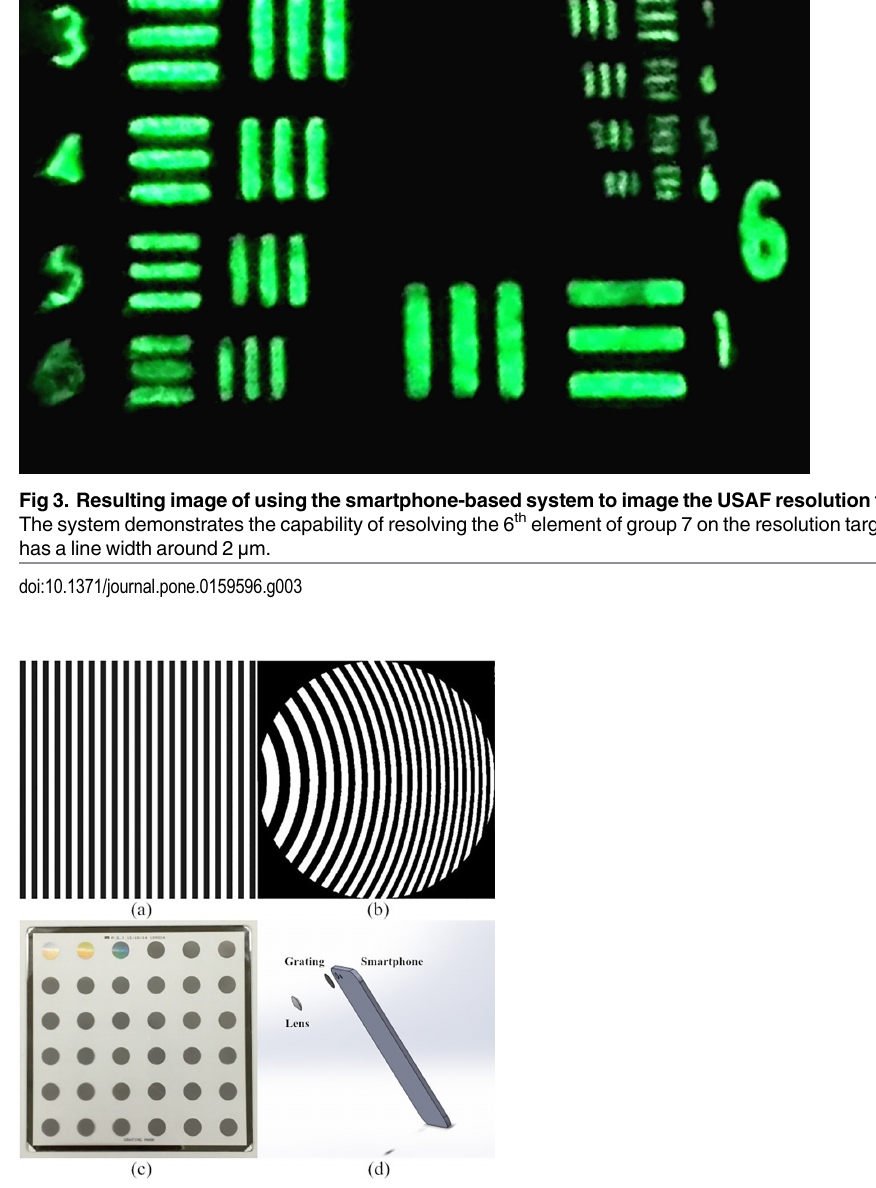
Fig 4. (a) Regular optical grating is consisted of periodical straight lines; (b) Quadratically distorted grating lines in a circular aperture; (c) Fabricated grating masks for smartphone devices, each of the dark circles is a mask; (d) System structure of the prototyping